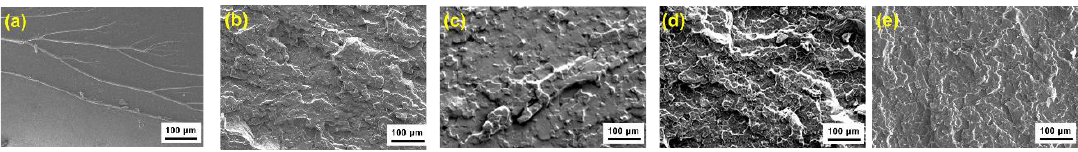
Figure 15. Scanning electron microscope (SEM) images of the fracture surfaces obtained after the monotonic tensile tests for ( a ) the specimens of neat epoxy and those with MWCNT:GNP ratios of ( b ) 10:0, ( c ) 0:10, ( d ) 3:7, and ( e ) 1:9.